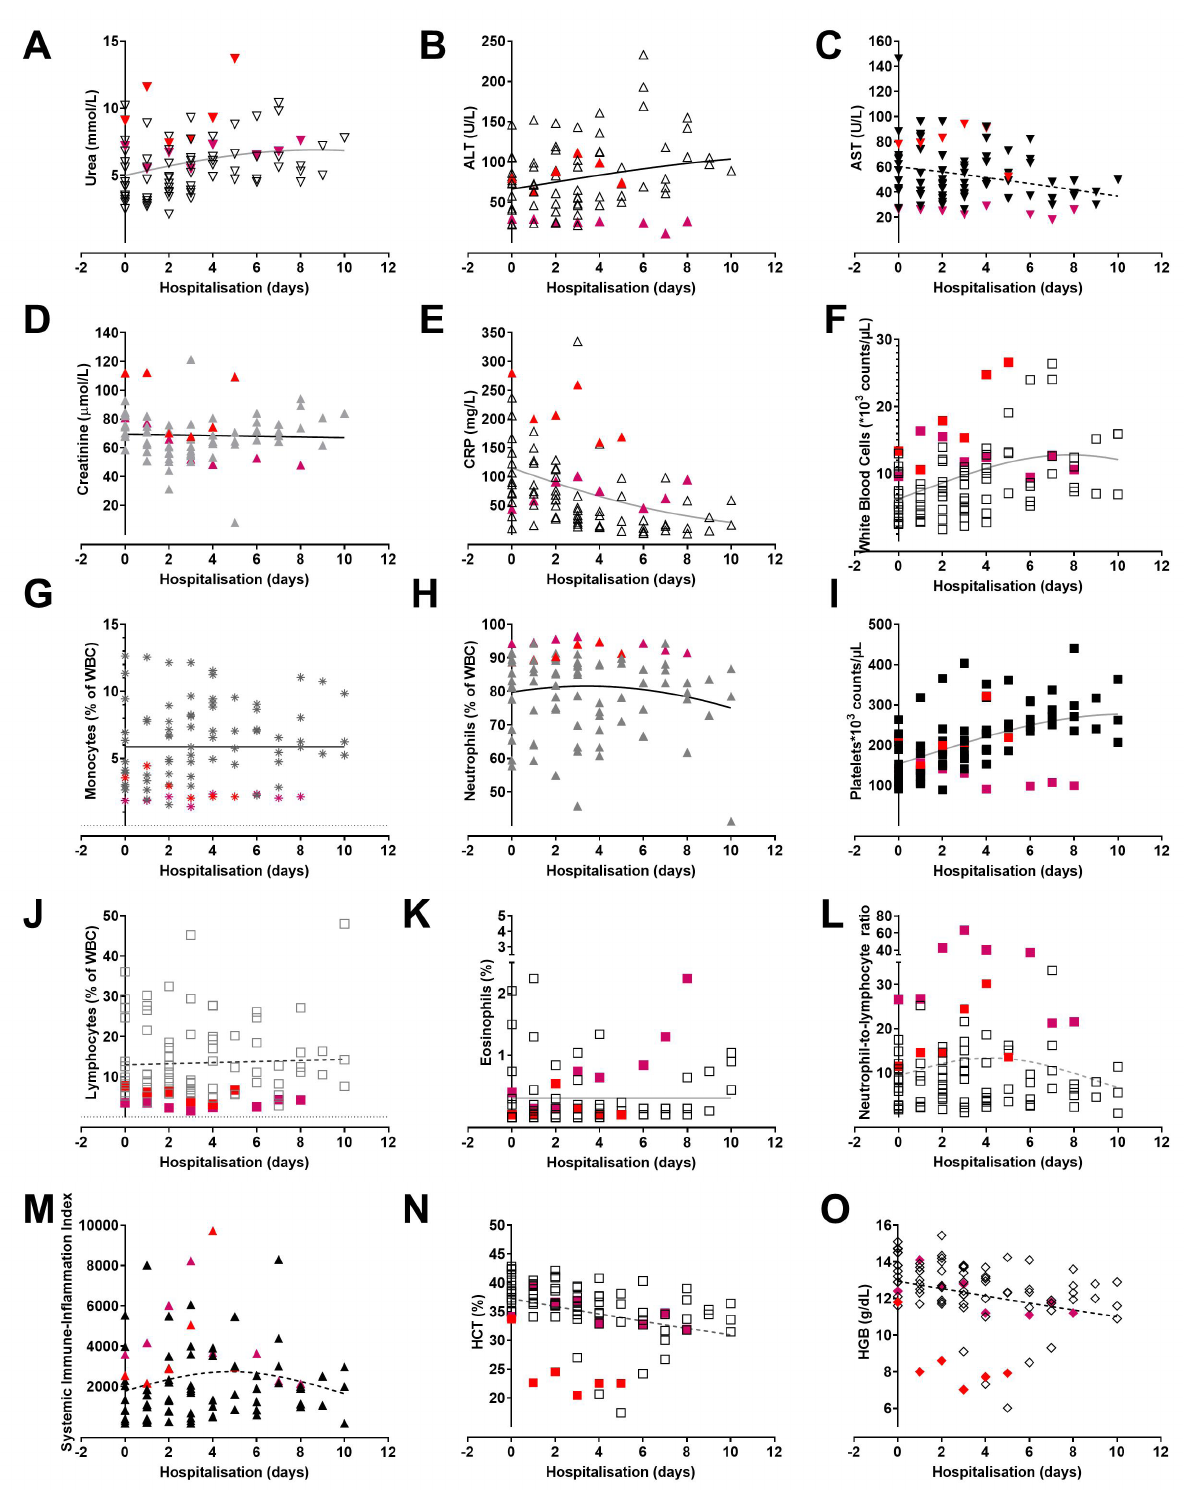
Fig. 4 - Biochemical parameters during hospitalisation. Graphs present an overview of selected biochemical parameters monitored for coronavirus disease 2019 severity. Red lines show a general trendline during hospitalisation. The red coloured symbols pertain a patient who succumbed as a result of acute respiratory distress syndrome. The coloured (red #1) (purple #2) symbols show the values for the two mortality cases. ALT=alanine aminotransferase; AST=aspartate aminotransferase; CRP=C-reactive protein; HCT=hematocrit; HGB=hemoglobin; WBC=white blood